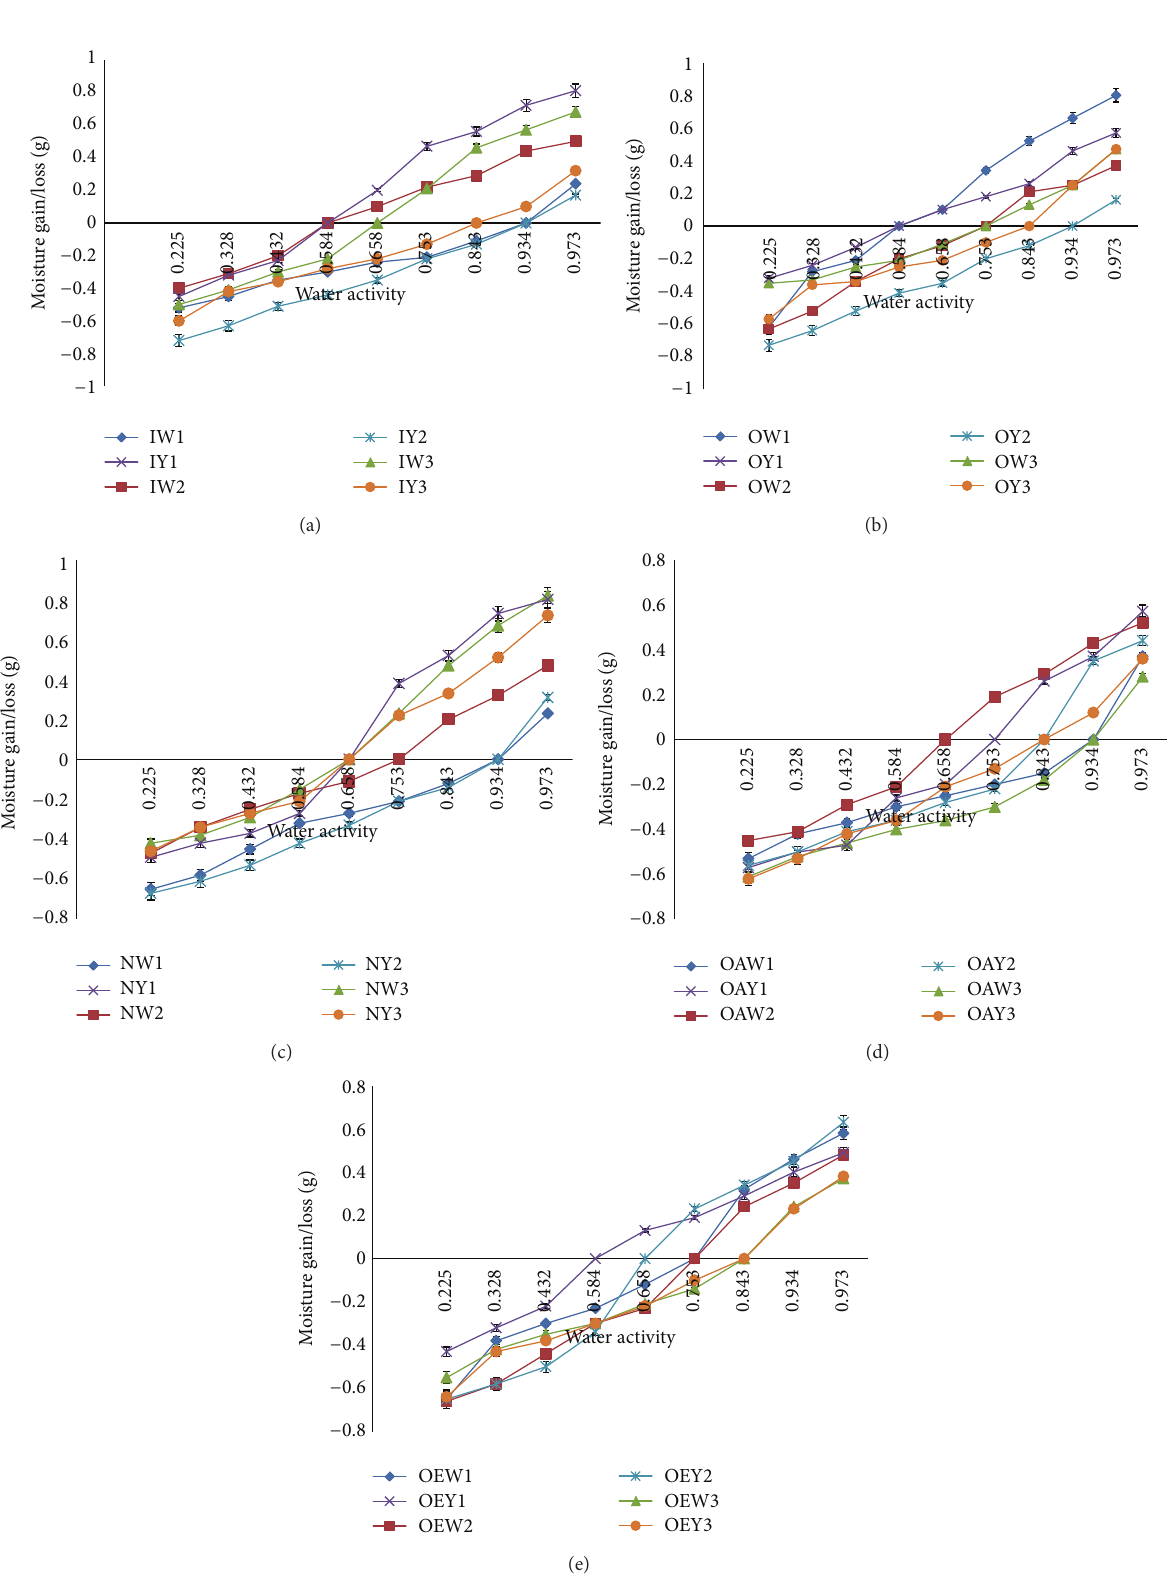
Figure 1: Water activity of garri samples (a) Ikpa, (b) Ogige, (c) Nkwo Ibagwa, (d) Obollo-Afor, and (e) Obollo-Eke (W: white; Y: yellow; 1–3 are different